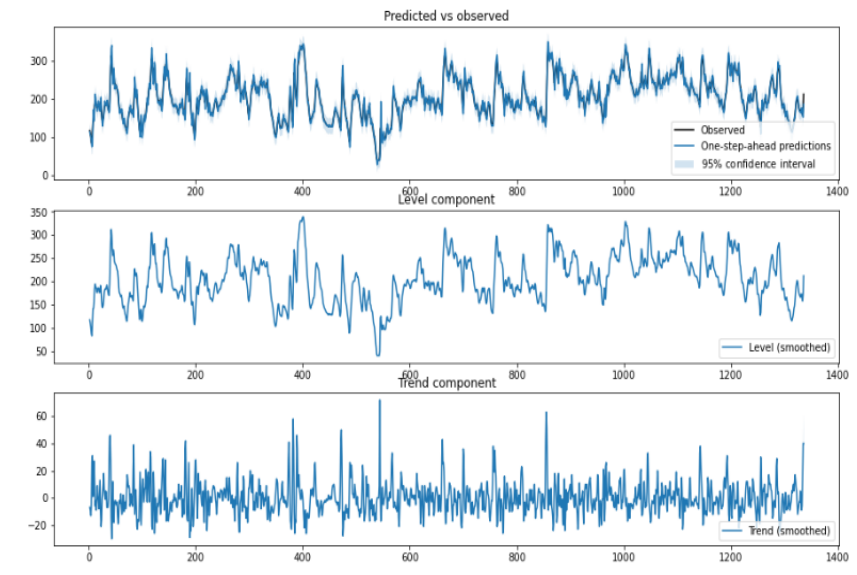
Figure 10. Structured Time-Series Analysis—The y-axis in the upper panel is BGL (mg/dL), and the time interval is 15